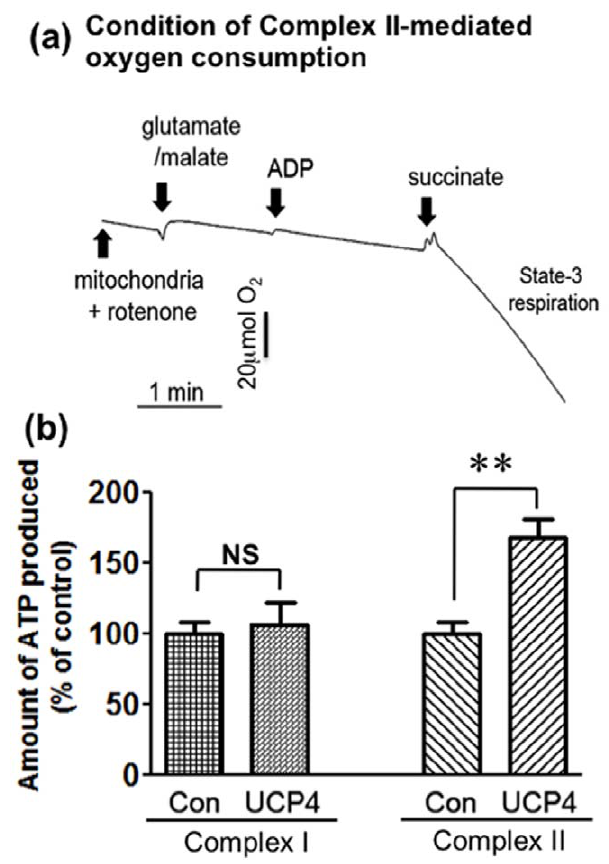
Figure 2. Complex II-specific oxygen consumption and ATP production of isolated mitochondria from UCP4-overexpress- ing and vector control cells. (a) Oxygraph showing specificity of Complex II-mediated respiration in isolated mitochondria induced by succinate. Addition of rotenone (10 m M) completely blocked Complex I activity, because addition of Complex I substrates (glutamate & malate) and ADP did not induce oxygen consumption. Subsequently, addition of Complex II substrate, succinate, induced oxygen consumption by state 3 respiration. (b) Amount of ATP produced in isolated mitochondria from vector and UCP4-overexpressing cells utilizing either Complex I or Complex II substrates. UCP4 overexpression facilitates ATP production using Complex II substrate (succinate). There was no difference in amount of ATP produced when using Complex I substrate (glutamate/malate). Basal value of ATP produced in vector control: glutamate/malate (Complex I)= 11.42 nmol ATP/mg mitochondria pro- tein/nmol O 2 ; succinate (Complex II): 6.68 nmol ATP/mg mitochondria protein/nmol O 2 . Results are expressed as mean 6 SEM based on at least four independent trials. ** represents statistical significance at p , 0.01, compared to the vector control cells. NS: not significant.